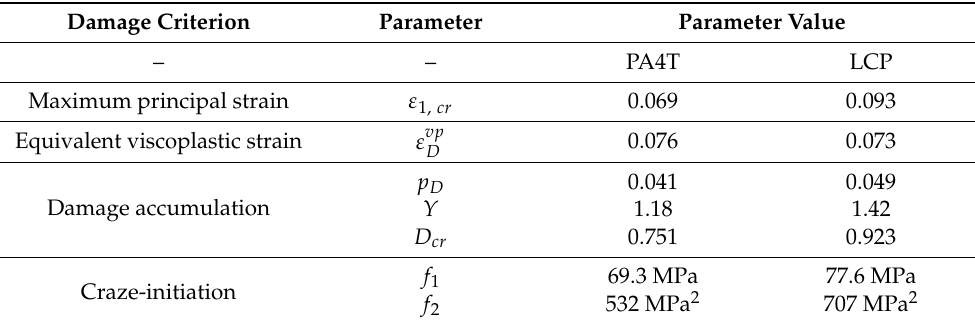
Table 2. Parameters adopted for various damage criteria.